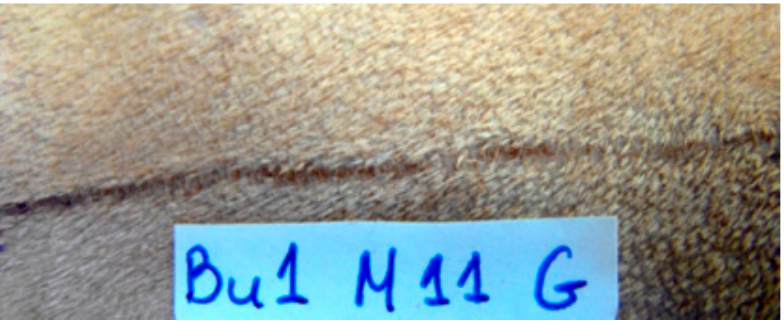
Figure 7. Hyperpigmentation at wound area closed with glue 11 months postoperatively.